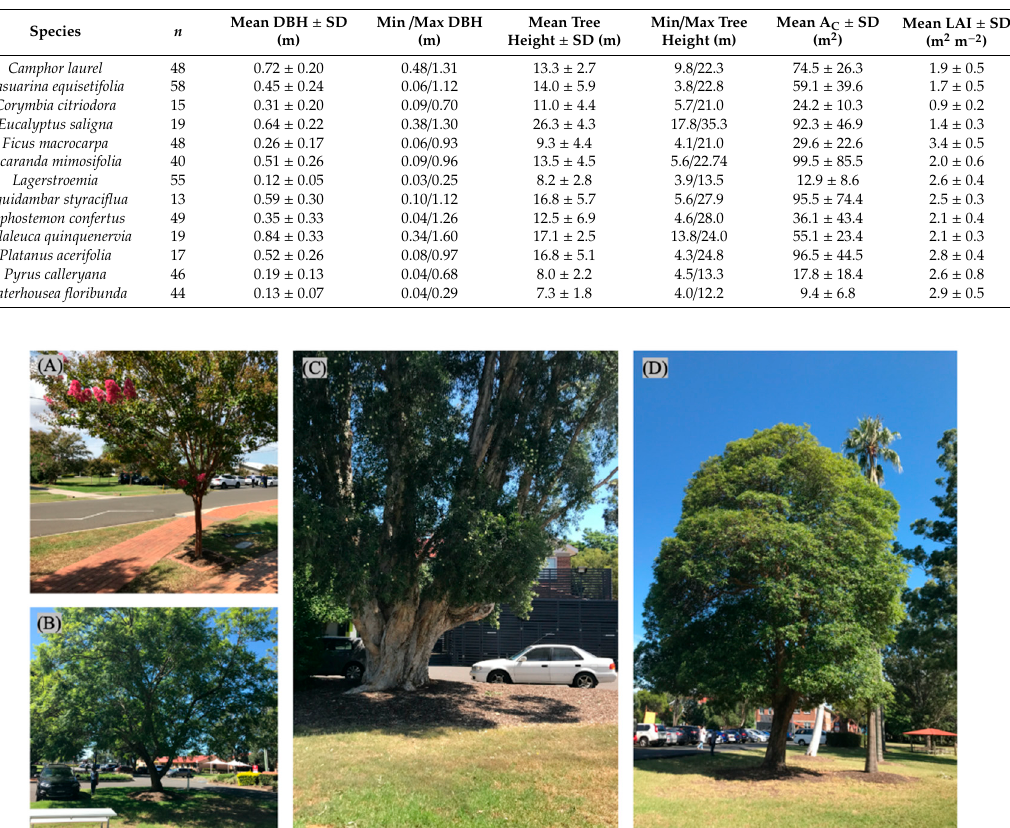
Figure 1. Examples of common tree species and surface types. ( A ) Crepe myrtle ( Lagerstroemia L.) with brick pavers and grass in sunlight and shade. ( B ) Jacaranda ( Jacaranda mimosifolia D.Don) with asphalt and grass in sunlight and shade. ( C ) Paperbark ( Melaleuca quinquenervia (Cav.) S.T.Blake) with bark mulch in sunlight and shade. ( D ) Queensland box ( Lophostemon confertus (R.Br.) Peter G.Wilson &